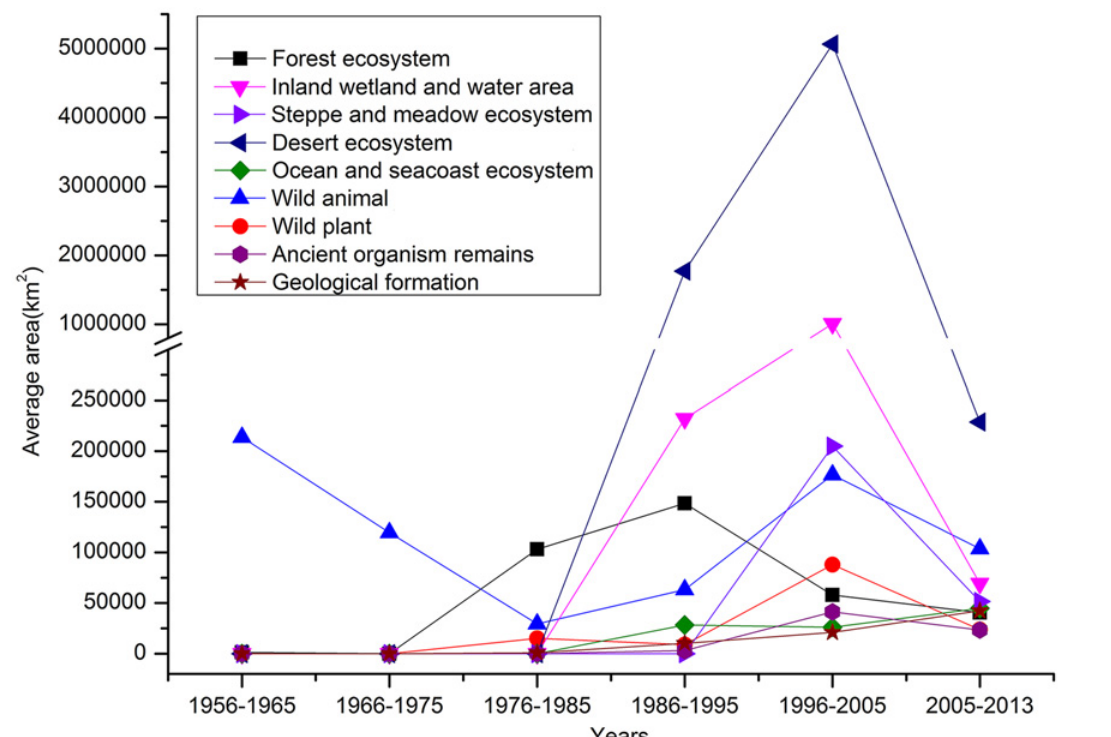
Fig 6. Average areas of different types of NNRs in different